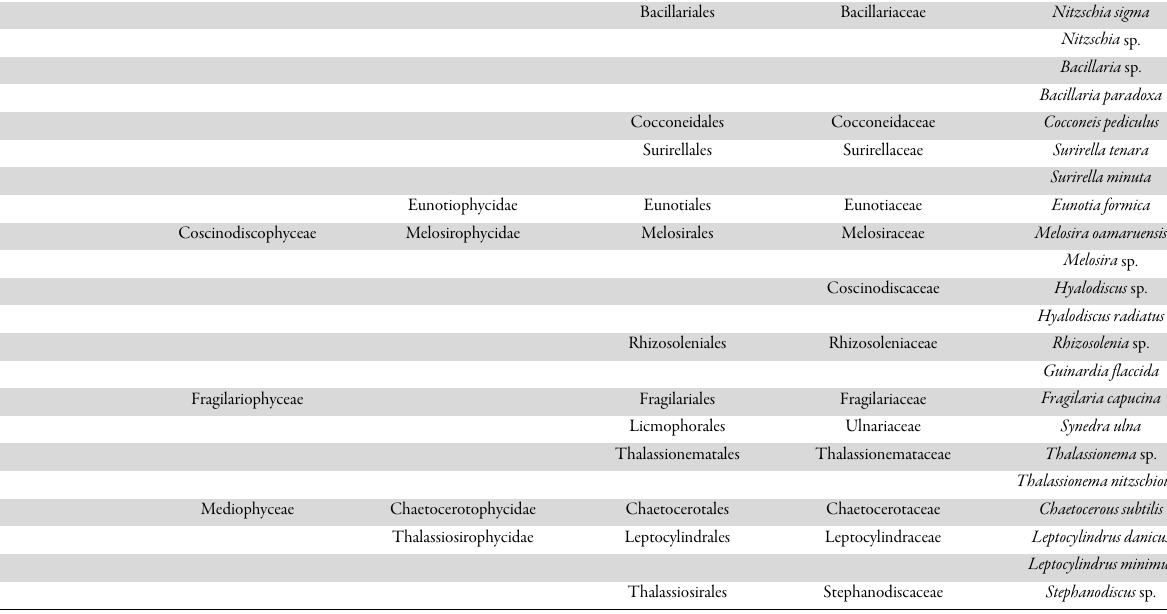
Table 2. Spatial and temporal abundance distribution of phytoplankton